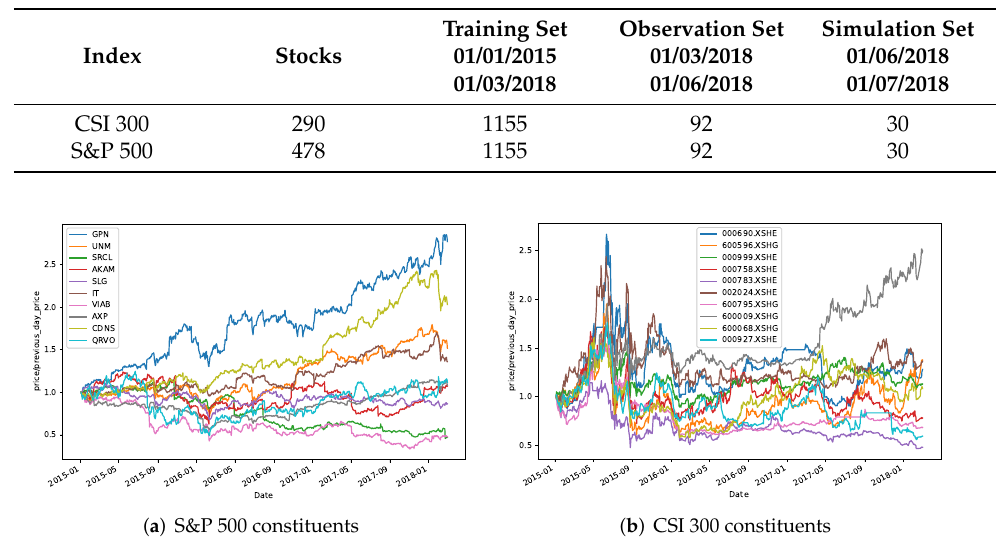
Figure 5. The closing price movements of randomly selected constituents from the S&P 500 ( a ) and CSI 300 ( b )